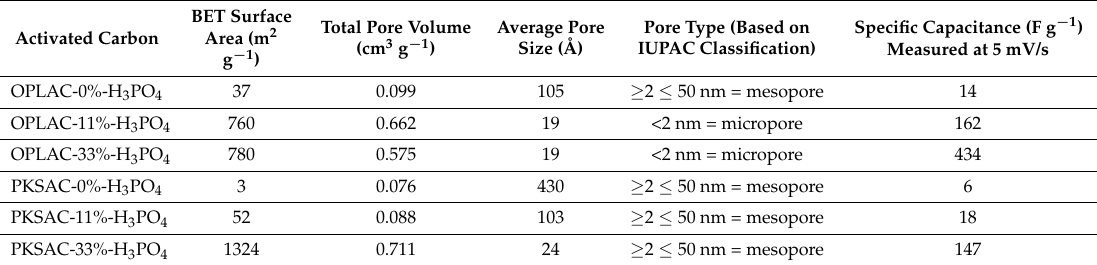
Table 1. Surface area, pore volume, average pore size, and specific capacitances of the as-prepared activated